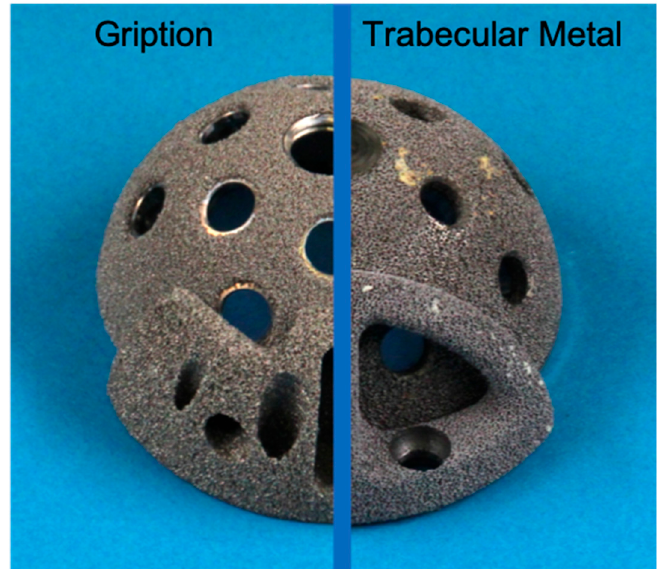
Figure 1. Photograph of titanium Gription cup and augment (left) and tantalum Trabecular Metal augment and cup (right) after implant explantation, demontrating the differences in their hole positions and augment geometry.